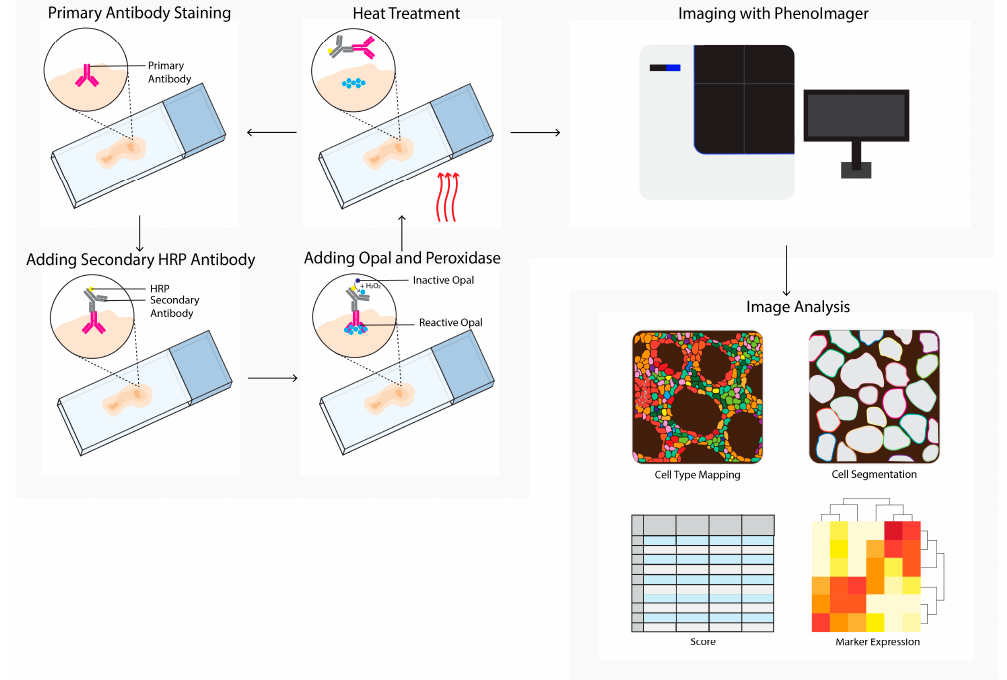
Figure 2. PhenoImager (Vectra) workflow. PhenoImager allows for the use of up to six primary antibodies (or eight in case of the high throughput version) and a nuclear stain. Antibody staining is performed in repetitive cycles of one primary antibody, a secondary horseradish peroxidase (HRP)- labeled antibody, followed by the addition of an opal polymer. HRP converts the opal fluorophore when peroxidase is present. Next, the primary and secondary antibodies are stripped by heat treatment, followed by the next staining cycle, and finally the tissue slide is analyzed using the PhenoImager microscopy system, resulting in data images. Cells in these images can be segmented and downstream analysis can be performed (e.g., cell type mapping and marker